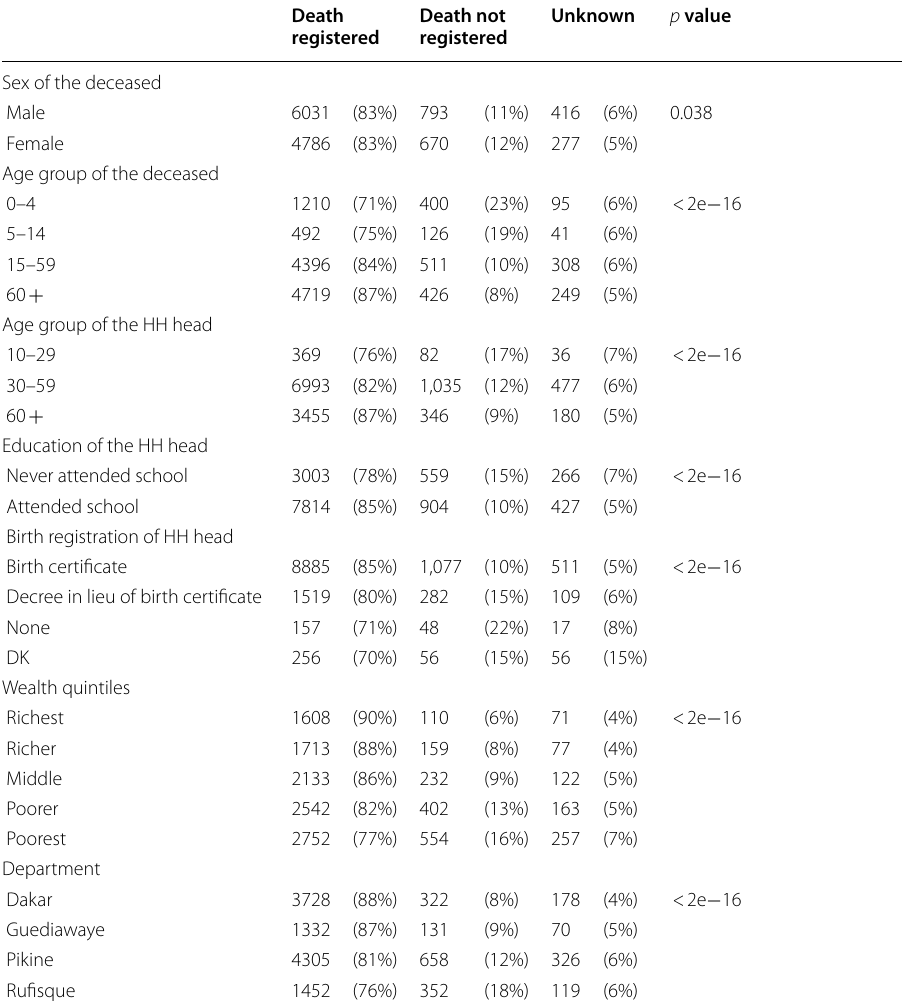
Table 3 Characteristics of deaths reported in the 2013 census in the Dakar region according to